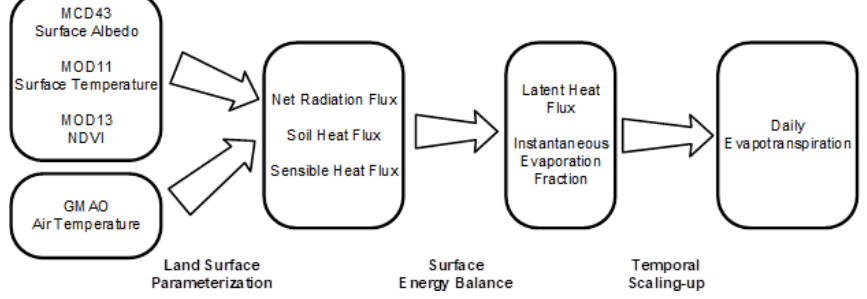
Figure 2. A flowchart of the Surface Energy Balance Algorithm for Land (SEBAL), which was used to convert multisource images to daily